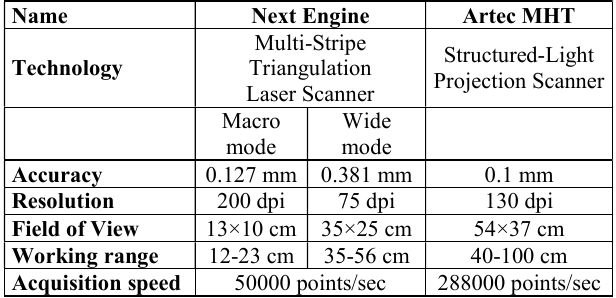
Table 1. Instruments specifications.